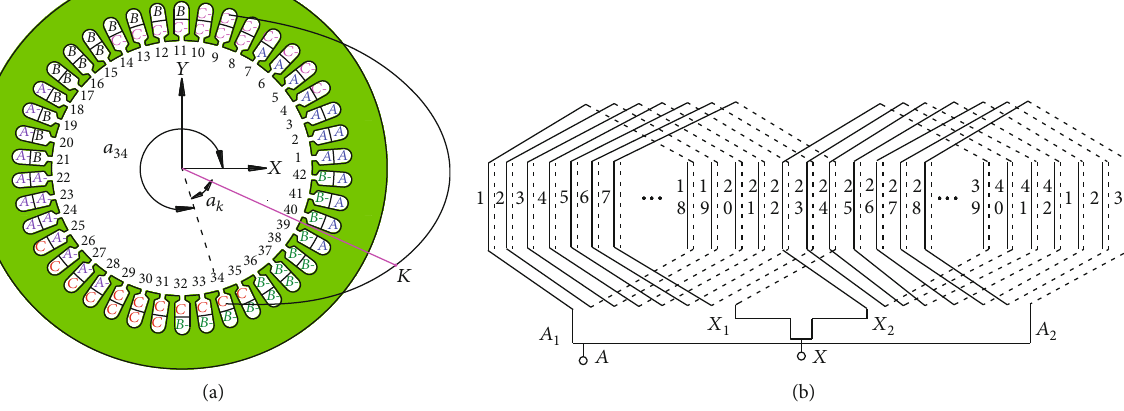
Figure 2: (a) Sectional view of three-phase winding distribution and (b) winding connection relationship of phase A.